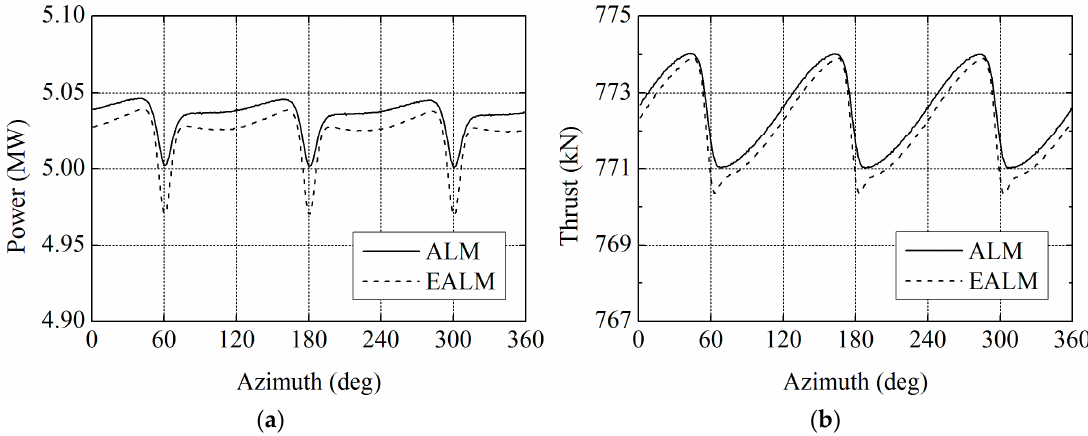
Figure 18. Comparisons of the aerodynamic performance results between traditional actuator line